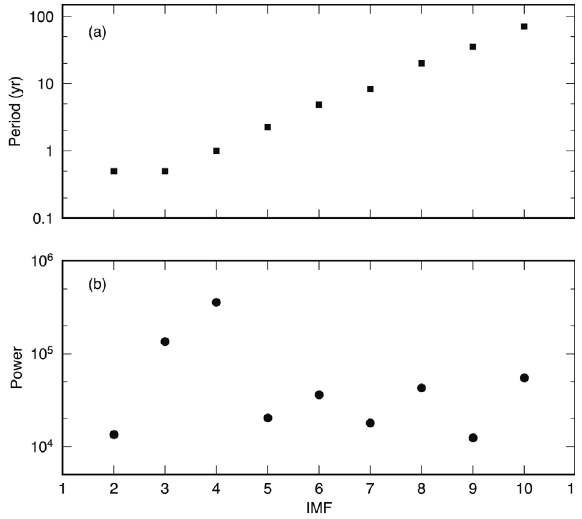
Figure 8. Fourier power spectrum analysis for the IMFk compo- nents of the AS curve. (a) Dominating period (in years); (b) Maxi- mum power, normalized by the IMF2 maximum power.